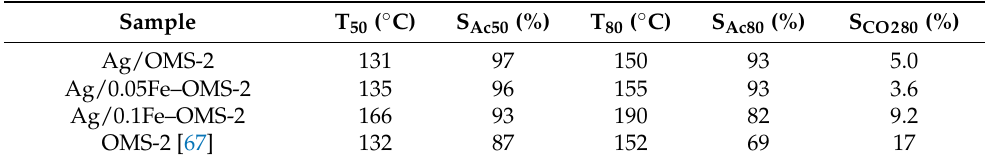
Table 4. Catalytic data for prepared catalysts in selective ethanol oxidation (GHSV = 7200 mL g − 1 h − 1 , Et/O 2 =